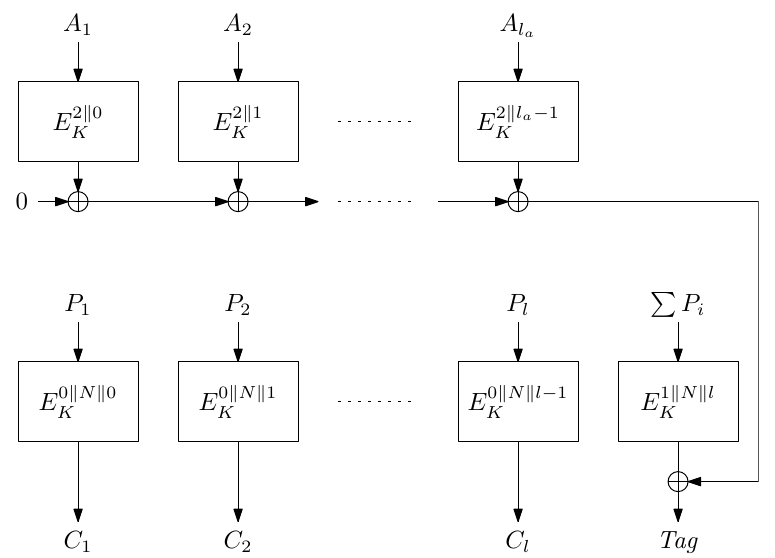
Figure 4: Sketch of the tweakable-block-cipher-based authenticated encryption scheme Deoxys-I